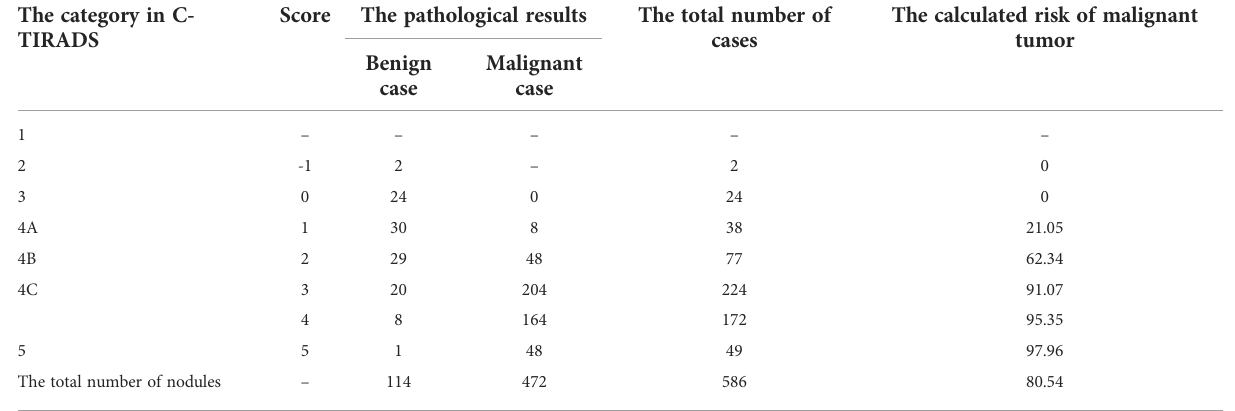
TABLE 3 C-TIRADS and pathological